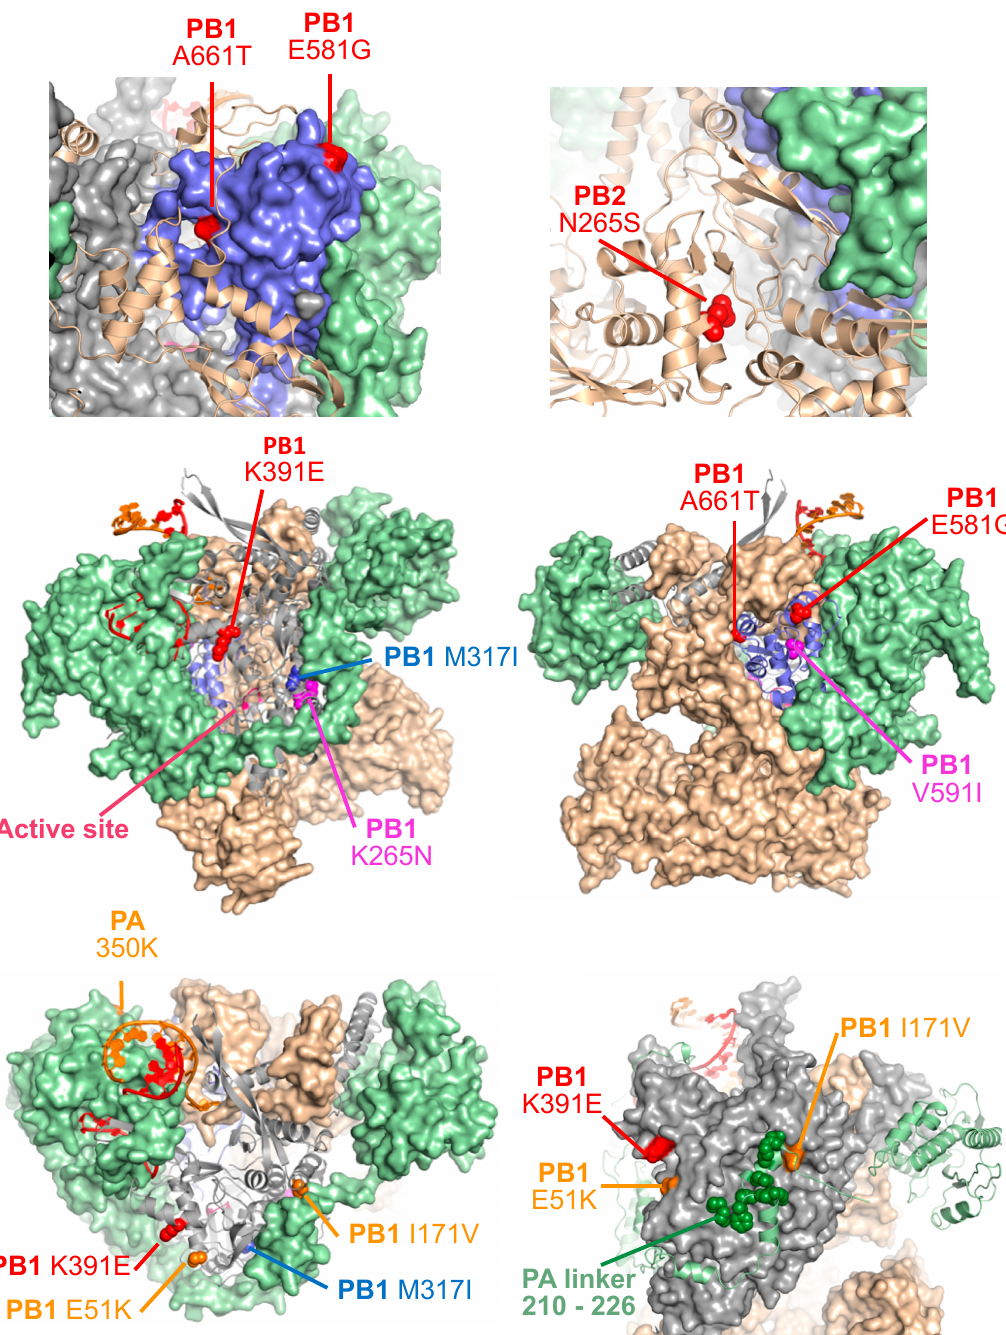
Figure 5. Attenuation and reversion mutations in the IAV polymerase complex. Attenuation mutations in the IAV polymerase: The locations of various IAV mutations found in the MDV LAIV and in revertant strains are shown as CPK spheres on the background of the polymerase complex colored as in Figure 2, with some subunits being shown as surfaces and others as cartoons in various orientations as needed for clarity. A dynamic version of this figure where the molecules can be rotated in real time is available on-lines as Figure S2. Mutations in the US LAIV MDV A/Ann Arbor/6/60 H2N2 are shown in red. Mutations present in the Russian LAIV MDV Len/17 or Len/47 (A/Leningrad/134/57 H2N2) strain are shown in magenta or blue, respectively. PB2 mutations V478L (Len/17) and S490R (Len/47) are not indicated in the structure. For more information see Figure 2 and Table 1. A set of engineered mutations in the PA subunit linker segment that wraps around PB1 are shown in green. Reversion mutations in PB1 (E51K, I171V) and PA (N350K) that restore virulence in the US LAIV MDV A/Ann Arbor/6/60 H2N2 (Table 2, green) are shown in orange.